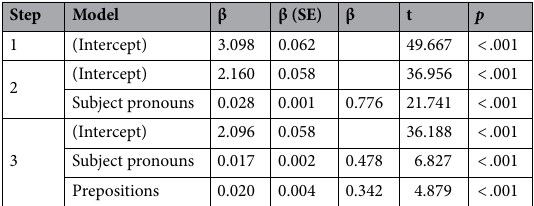
Table 4. Regression model predicting MLU-w on Function Words.